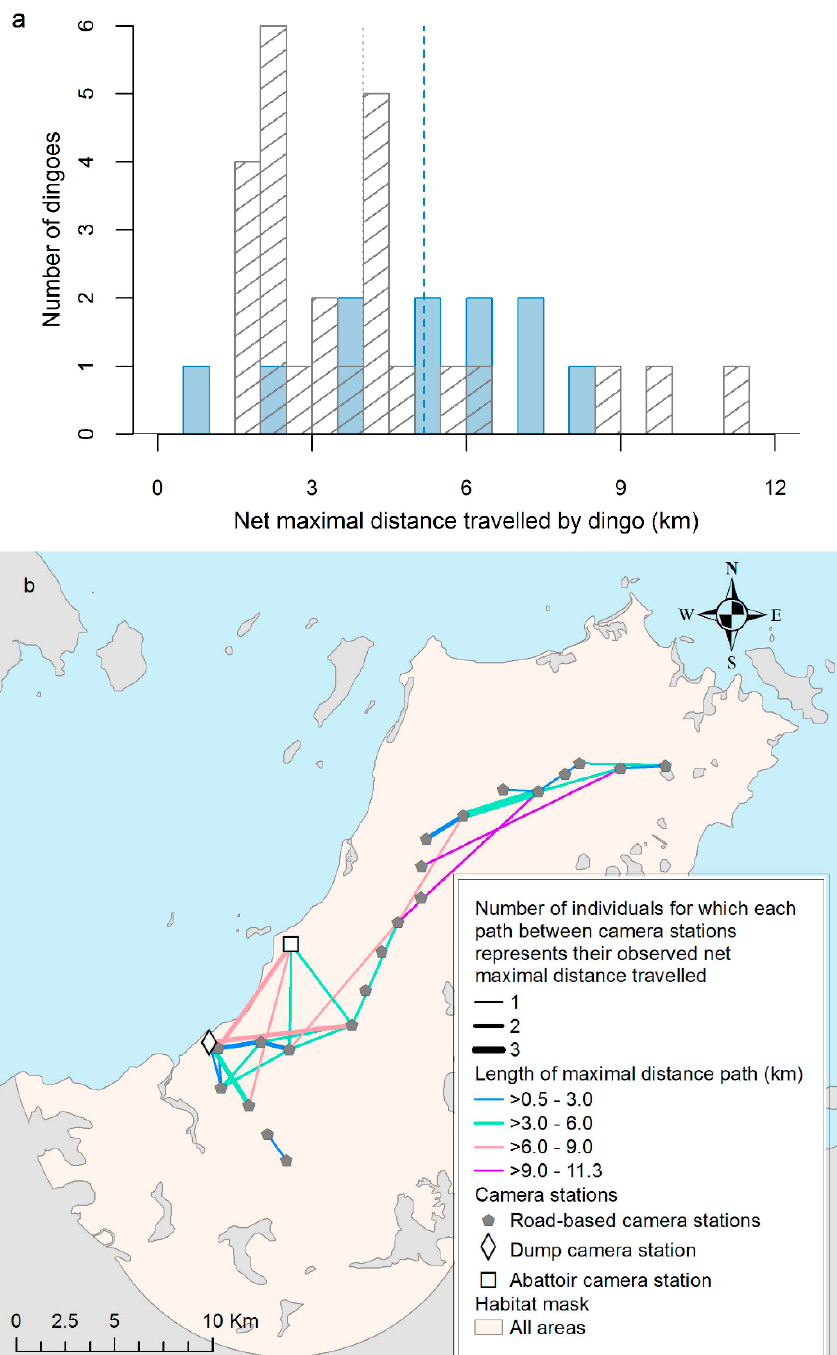
Figure 2. ( a ) Histogram and ( b ) spatial distribution of the paths representing the observed net maximal distance travelled for each marked individual moving dingo (n = 36 dingoes) between the two camera stations furthest apart per individual, based on a camera trap study conducted in the Northern Peninsula Area (NPA) of Queensland, Australia, from May 2016 to May 2017. In ( a ), the two types of paths were compared: paths between a focal point station and a road-based station (blue bars) or between two road-based stations (diagonal gray bars). The mean net maximal distance is shown with the dashed blue line for focal–road paths and the gray dotted line for road–road paths. The connections in ( b ) were weighted according to the number of individuals for which each path represented their net maximal movement observed.